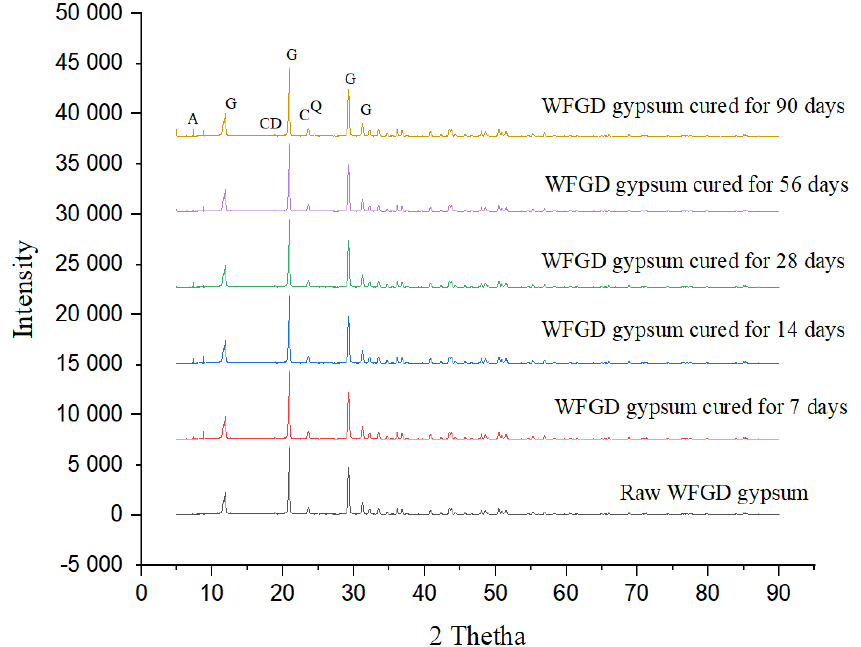
Figure 8. XRD of raw composites cured at ambient temperature (A = sillimanite, Q = quartz, CD = calcium dialuminate, C =